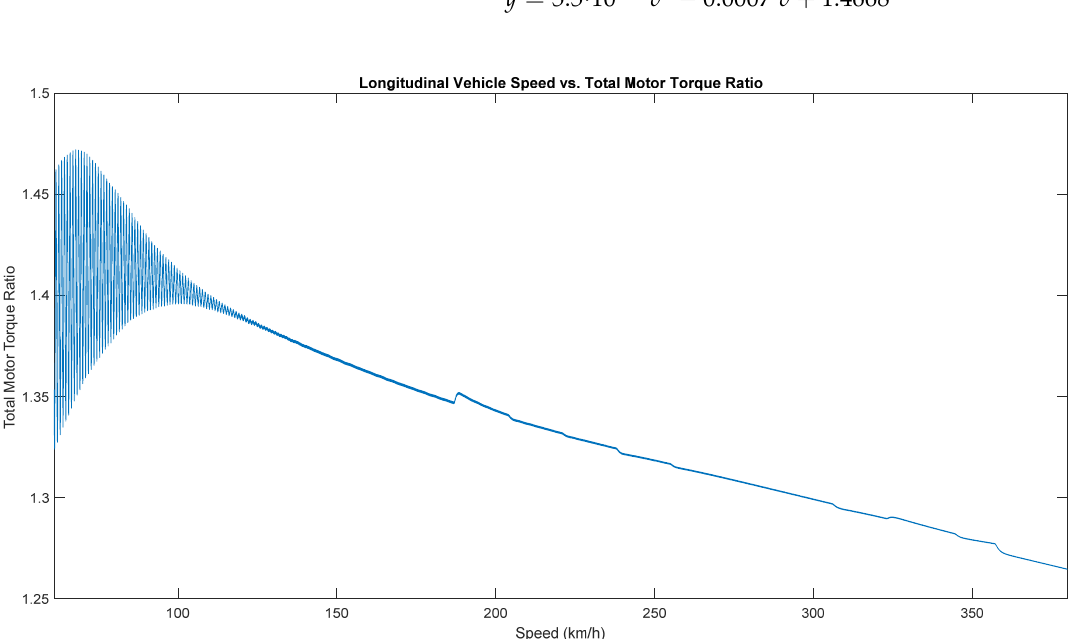
Figure 19. Ratio between the TEST and PROPS torques vs. vehicle speed.